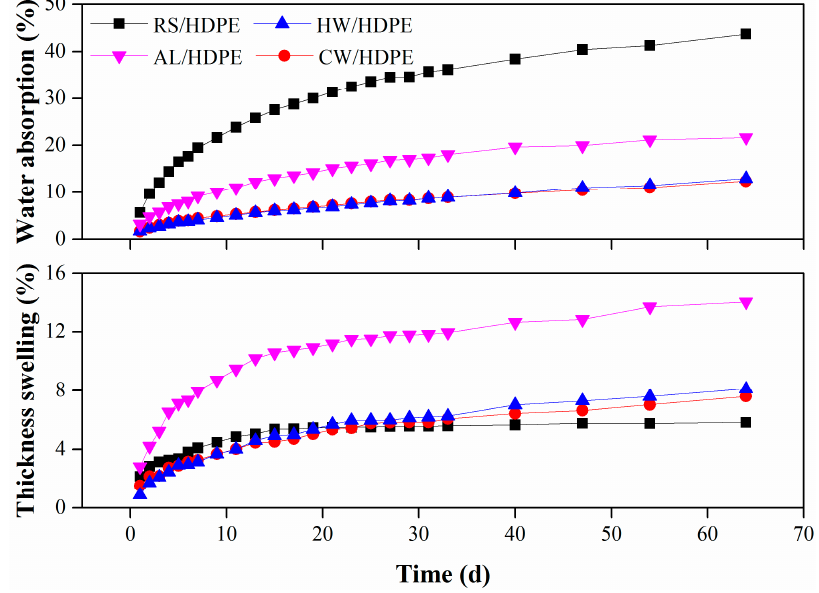
Figure 3. Water uptake of RS/HDPE, CW/HDPE, HW/HDPE, and AL/HDPE.